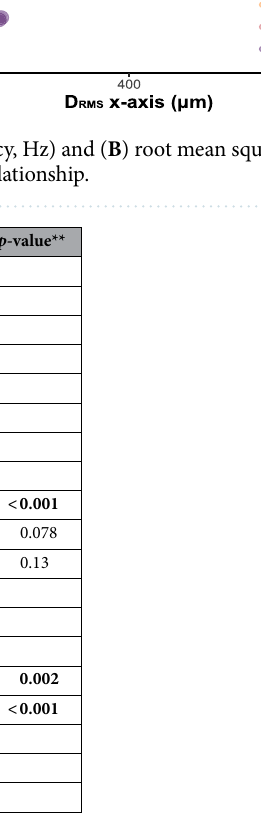
Table 1. Parameter estimates of the linear models fitted with either dominant frequency (Hz) or D RMS as response, and forceps dominant frequency or D RMS , anther type, and species as explanatory variables. * P- value of explanatory variable in linear model. ** P- value calculated using Type III sums of squares. Sample size is 150 for both models.